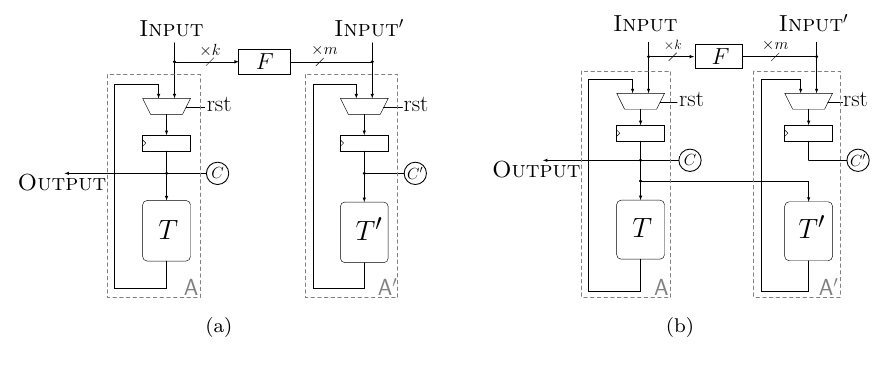
Figure 2: The constructions proposed in